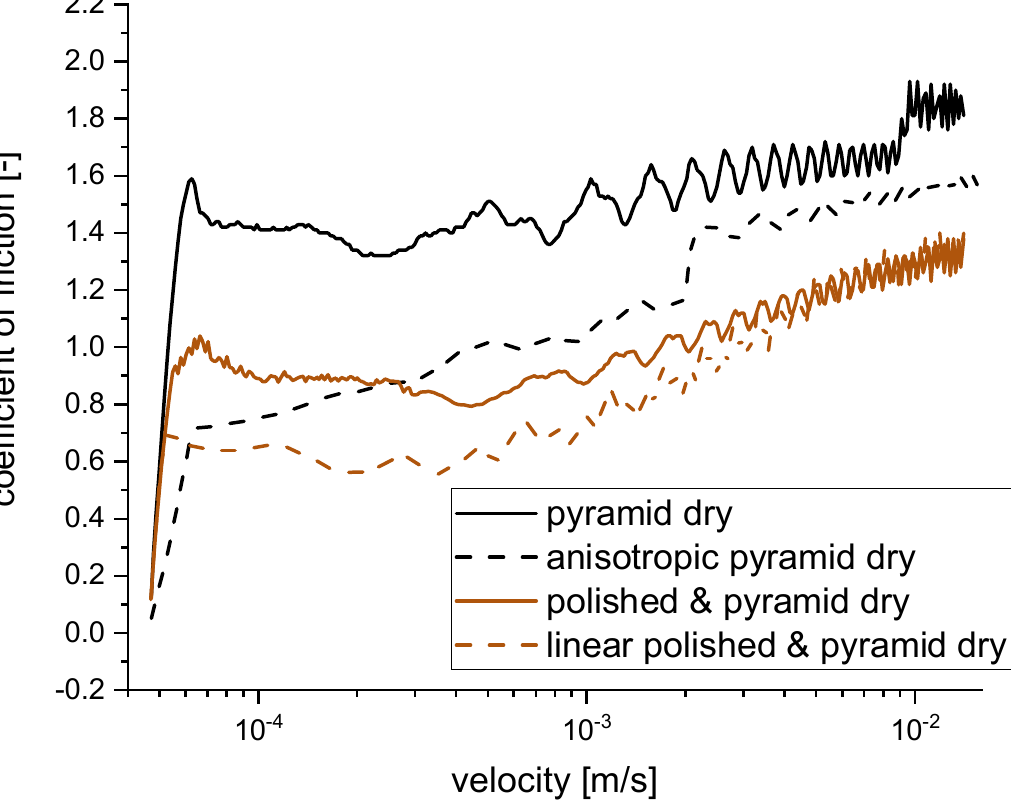
Figure 10. Dry frictional behavior with anisotropy for pyramid-structured and polished surfaces.